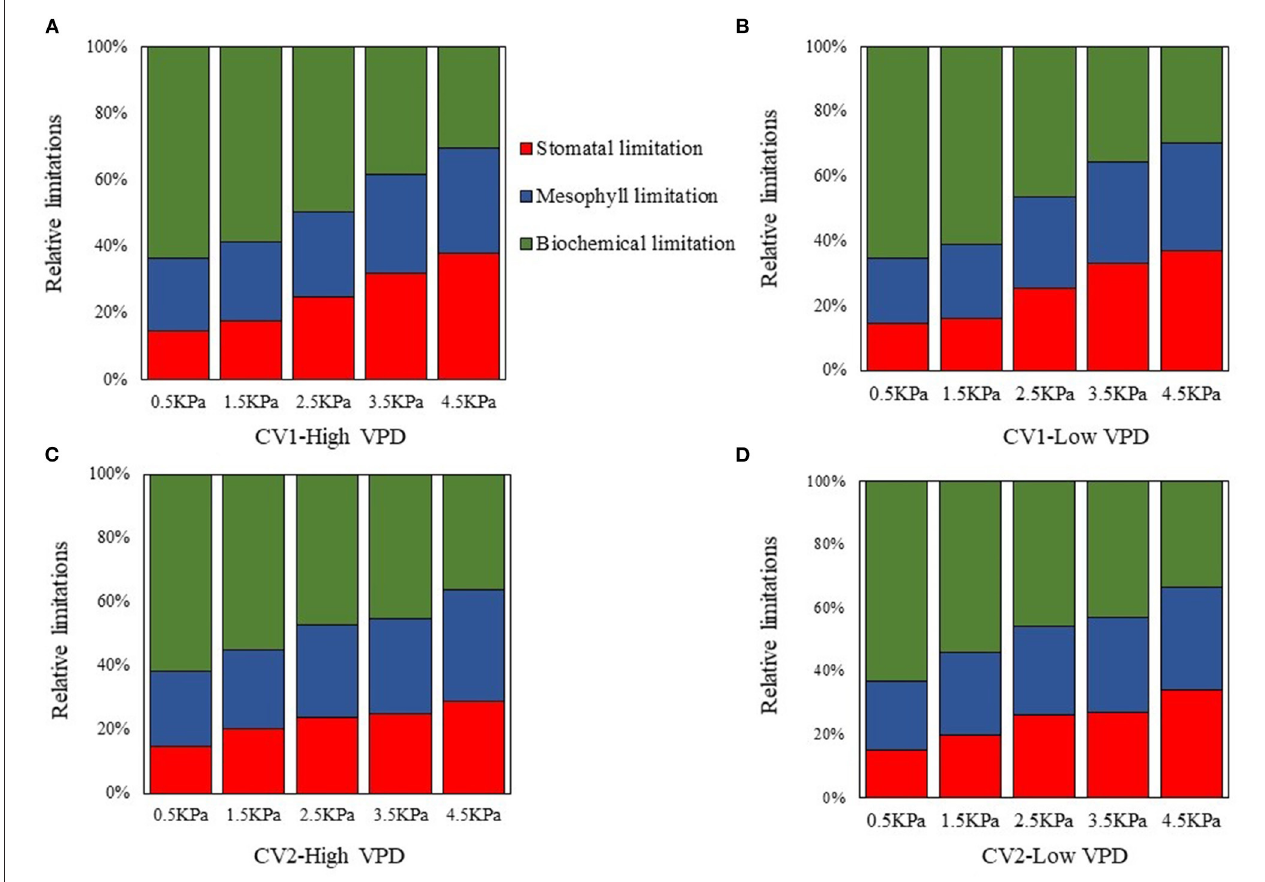
FIGURE 5 | The dynamic changes in the relative proportions of individual components of photosynthetic limitations across VPD ranges: (A) CV1 grown under high VPD condition; (B) CV1 grown under low VPD condition; (C) CV2 grown under high VPD condition; and (D) CV2 grown under low VPD condition.